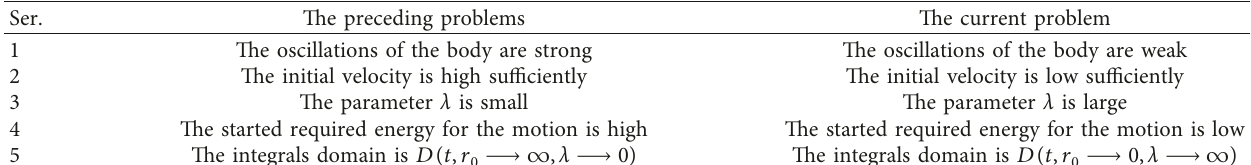
Table 1: Distinctions between the prior issues and one being considered.